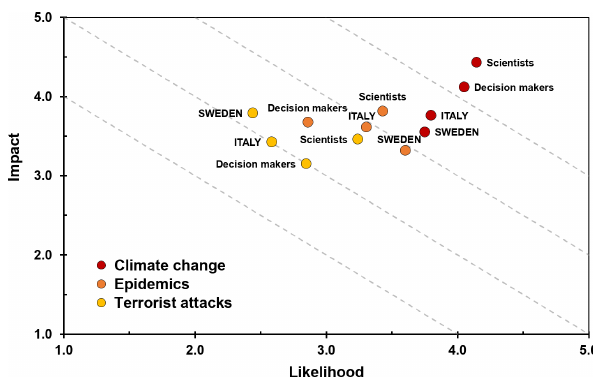
Figure 5. Public risk perceptions in Italy and Sweden associated with climate change, epidemics and terrorist attacks compared with perceptions of scientists from the global change research commu- nity, i.e., 2020 Future Earth’s Survey, and decision makers around the world, i.e., the 2020 Global Risks Report by the World Eco- nomic